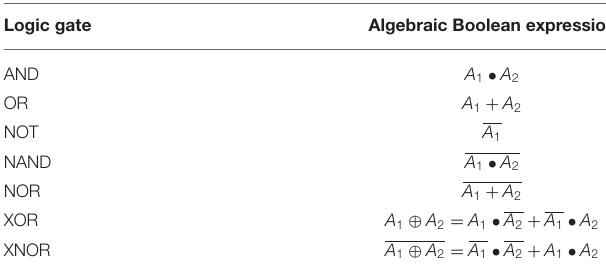
TABLE 1 | Two-input logic gates and one-input inverter NOT. Logic